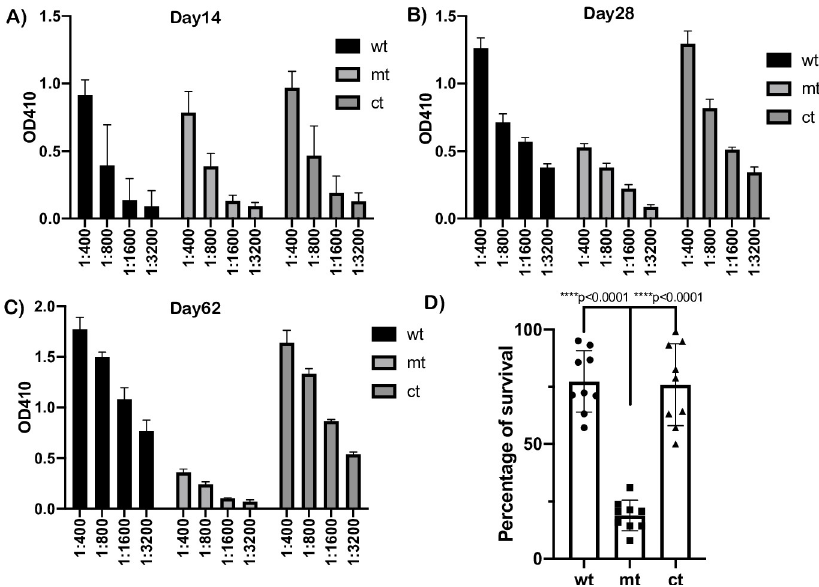
Fig 15. Seroconversion and borrelicidal antibody responses in C3H/HeN mice. Serological response in C3H/HeN mice infected with wt, mt and ct by needle inoculation at day (A) 14, (B) 28 and (C) 62 post-infection. Antibody responses in serum from wt, mt and ct infected mice were measured using ELISA plates with whole wt Bb lysate coated as antigen. Serial two-fold dilution starting at 1:400 dilution was used and plates developed using HRPO-conjugated anti-mouse whole Ig antibodies and plates developed using ABTS as substrate and absorbance measured at OD 410 nm using BIOTEK Synergy ELISA reader. Data shown are means of three technical replicates with error bars representing Standard Error Mean and is representative of one of the three experiments. (D) Wt, mt and ct strains were treated with intact or heat inactivated guinea pig complement in the presence day 14 serum from C3H/HeN mice infected with the mt as described in the materials and Materials and Methods. Survival percentage of spirochetes was determined by number of motile spirochetes from intact complemented treated sample in comparison to heat inactivated sample. The levels of significance were determined using unpaired t test with GraphPad Prism software and a p value of less than 0.5 was considered as significant.